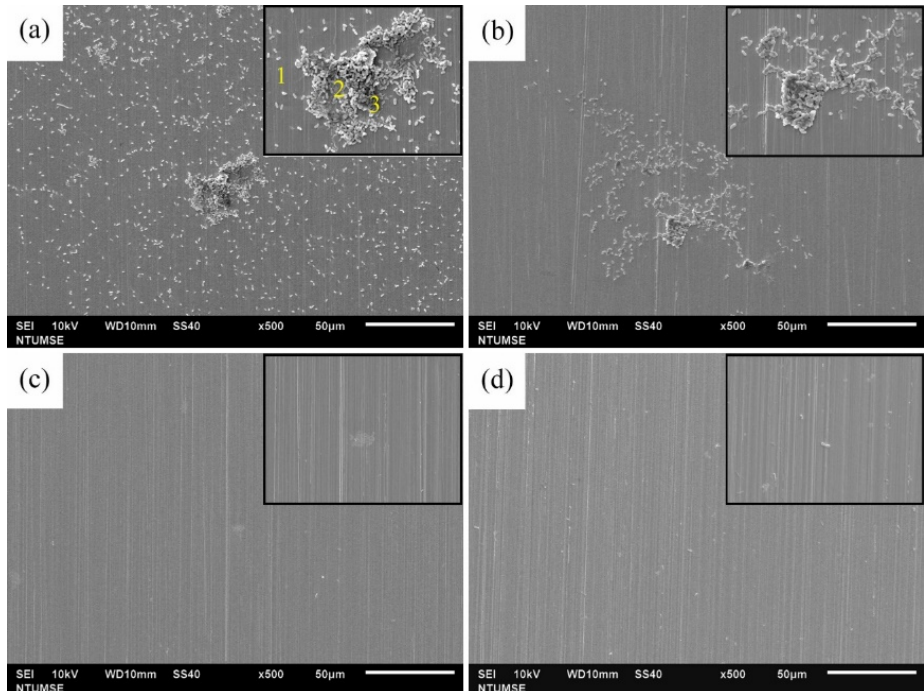
Figure 6. SEM images of the 304 SS surface after ( a ) 12 h and ( b ) 336 h of exposure to the uninoculated culture medium.